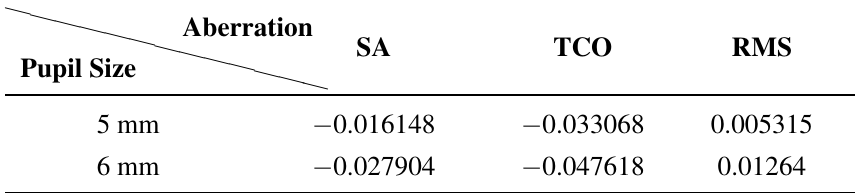
Table 2. Third-order aberrations in the initial human eye model. SA: spherical aberration; TCO: tangential coma; RMS: root mean square.